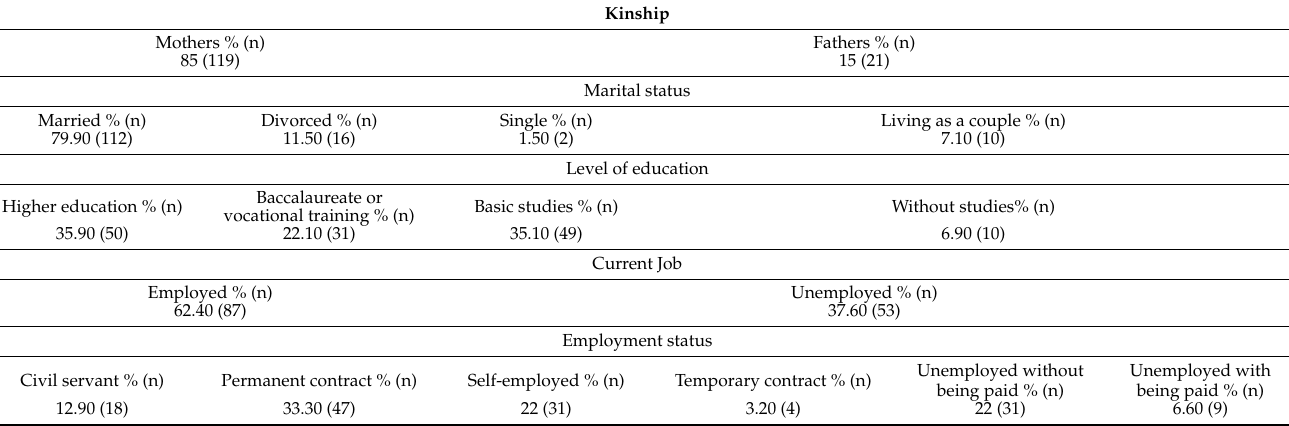
Table 2. Socio-demographic characteristics of the participants (n =